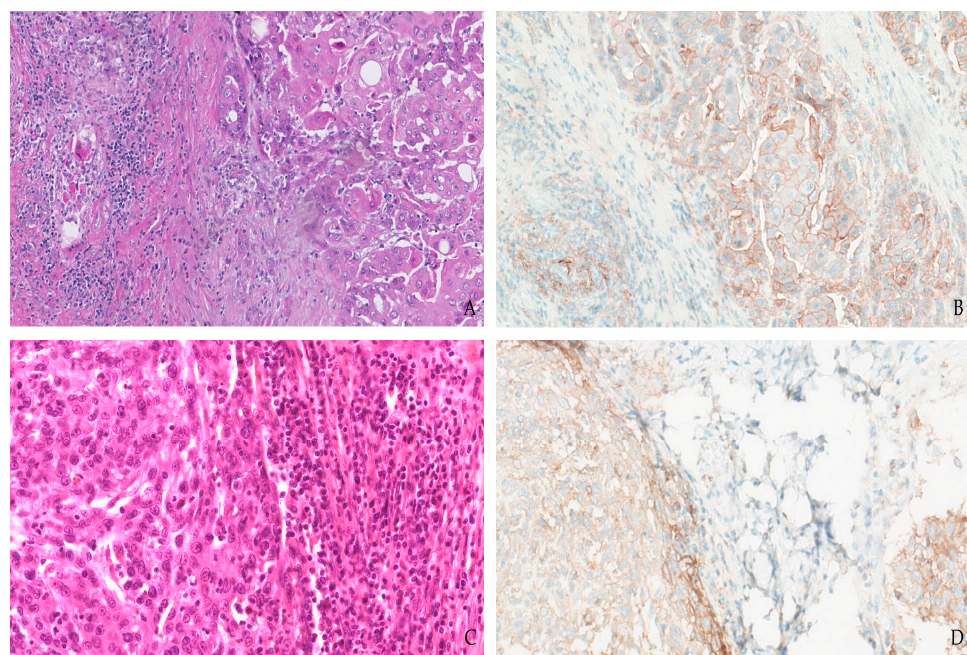
Figure 4. Combined proportion score (CPS) in head and neck cancer. Hematoxylin and eosin stain ( A , C ) show two examples of squamous cell carcinoma rimmed by tumor-infiltrating lymphocytes (TIL). Immunohistochemical analysis of PD-L1 expression with 22C3 clone labeling almost all tumor cells and a noteworthy proportion of TIL, resulting in a CPS = 80 ( B ). Assessment of PD-L1 staining with the SP263 antibody revealing homogenous membranous expression by neoplastic cells and partial positivity of peripherical TIL for an overall CPS = 75 ( D ).